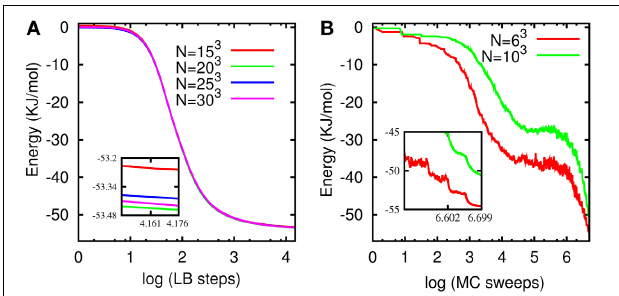
FIGURE 12 | (A) Potential energy for the water model based on the LTIP3P vs. LB steps with τ/(cid:3) t = 20 (over-relaxation regime) and γ = 50 (cid:3) t − 1 for different system sizes. (B) Potential energy vs. (simulated annealing) MC sweeps for two different system sizes. The insets zoom into final